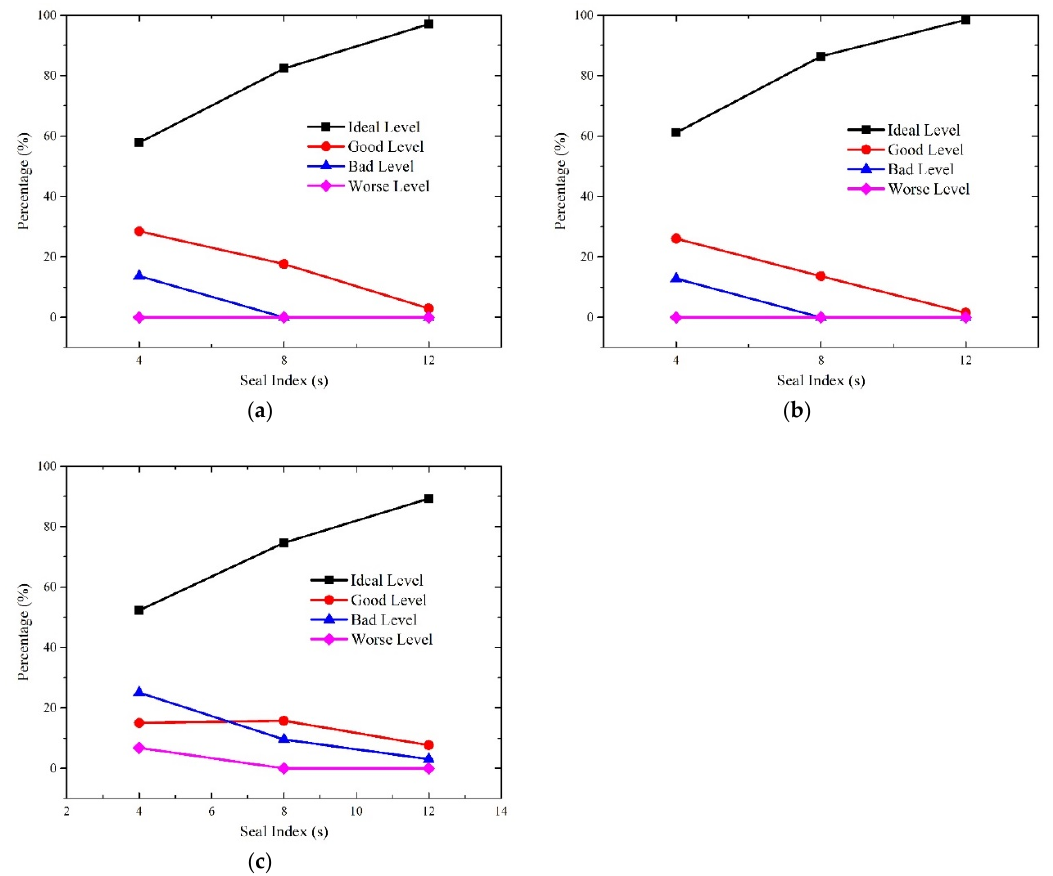
Figure 10. The relationship between seal index and aural discomfort. ( a ) I1; ( b ) I2; ( c ) I3.